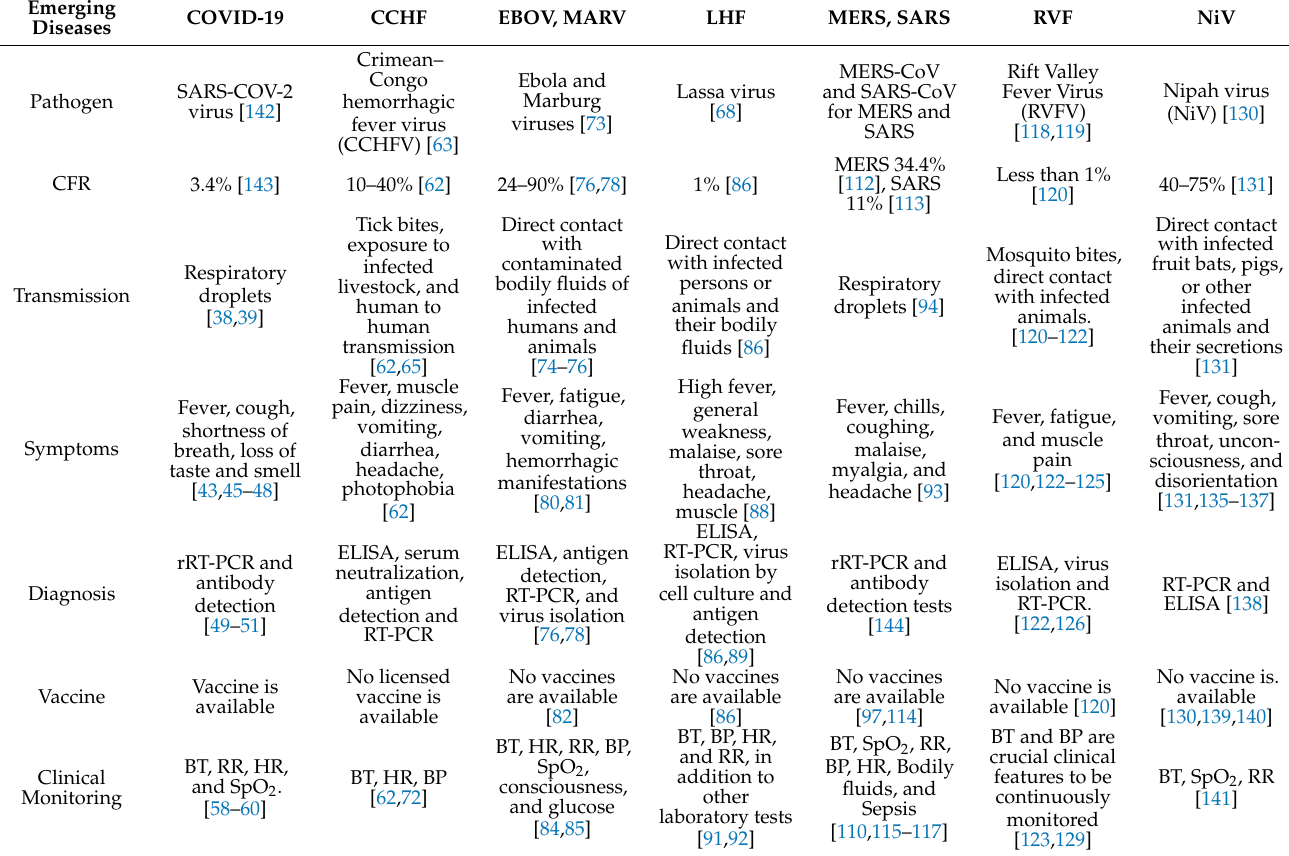
Table 1. Summary of reviewed infectious diseases highlighting the pathogen causing the disease, modes of transmission, case fatality rate, symptoms, diagnosis methods, vaccine availability, and clinical management. Emerging